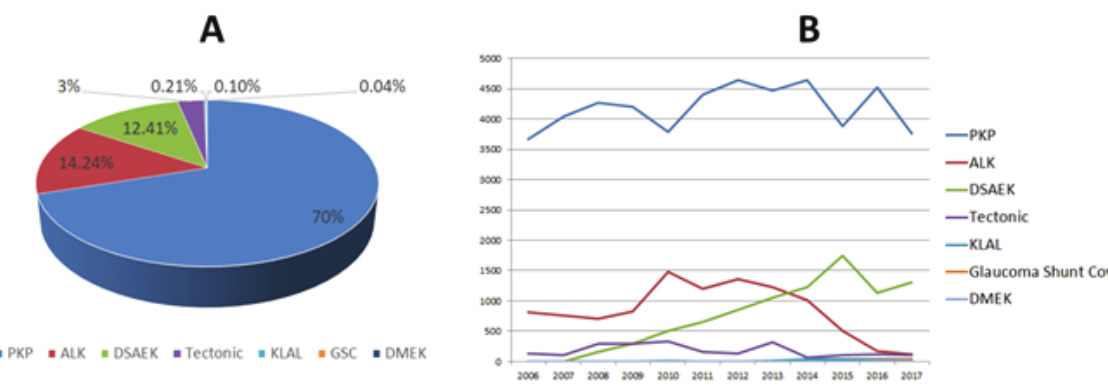
Figure 3. The mean rate of transplantation procedures and their corresponding relative trends. (A) penetrating keratoplasty was the most common keratoplasty procedure (70%) over the last 12 years, followed by anterior lamellar keratoplasty (14.24%), Descemet stripping automated endothelial keratoplasty (12.41%), tectonic (3%), keratolimbal allografts (0.21%), glaucoma shunt coverage (0.10%), and Descemet membrane endothelial keratoplasty (0.04%). (B) The relative trends of corneal transplantation techniques between 2006 and 2017 were illustrated.ALK, anterior lamellar keratoplasty; DMEK, Descemet membrane endothelial keratoplasty; DSAEK, Descemet stripping automated endothelial keratoplasty; KLAL, keratolimbal allografts; GSC, glaucoma shunt coverage; PKP, penetrating